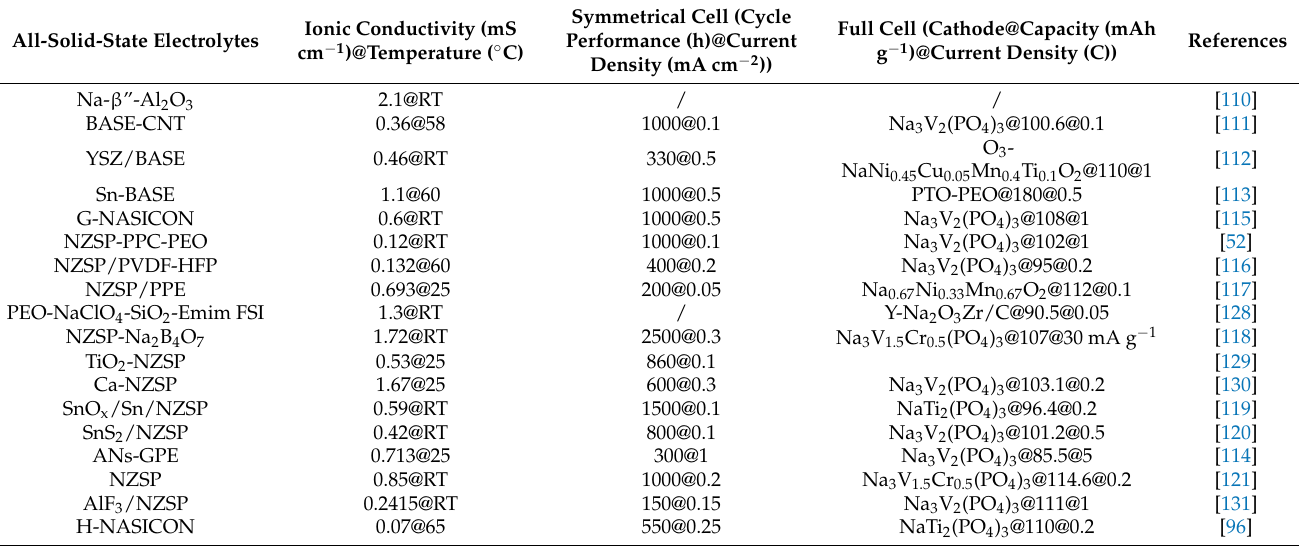
Table 3. Electrochemical properties of different all-solid-state electrolytes in NMBs.